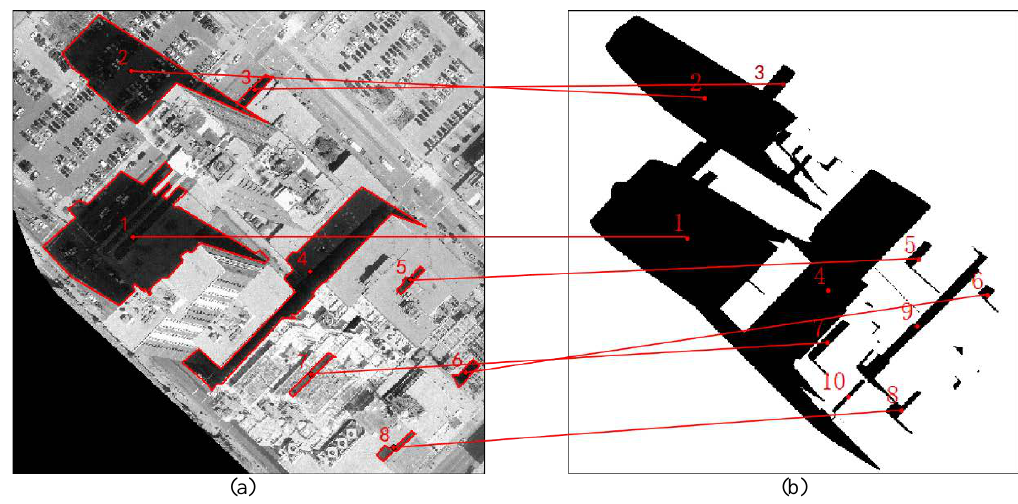
Figure 4. Local shadow matching image